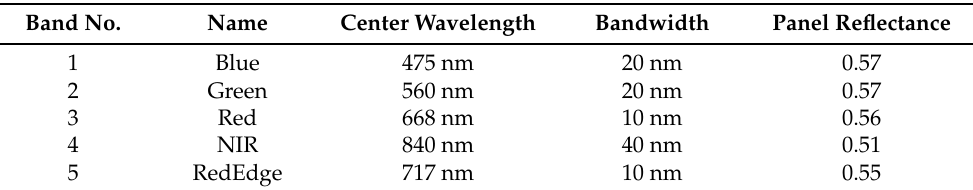
Table 1. Detailed spectral information of the RedEdge camera.